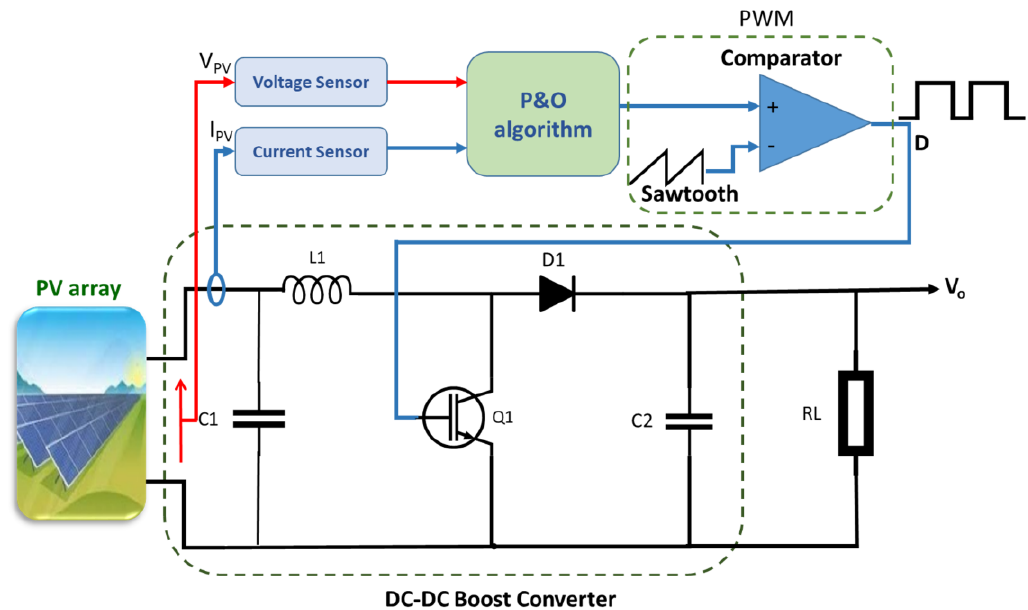
Figure 6. Schematic diagram of boost converter with MPPT controller. Table 2. Design parameters of the boost converter circuit.